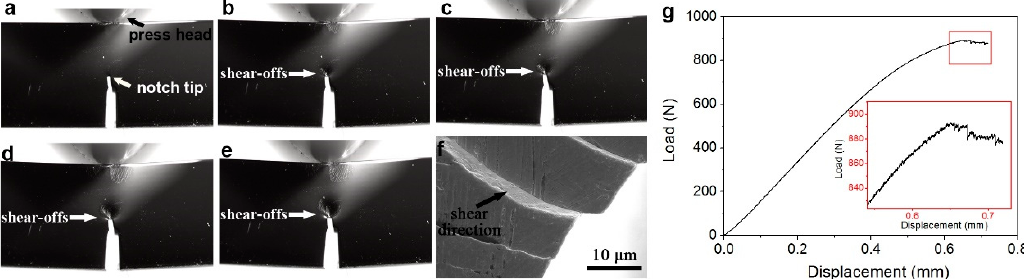
Figure 1. ( a – f ) The side view of a Pd 77.5 Cu 6 Si 16.5 metallic glass (MG) sample with a size of 3 × 6 × 30 mm 3 during 3-point bending test. ( g ) The load-displacement